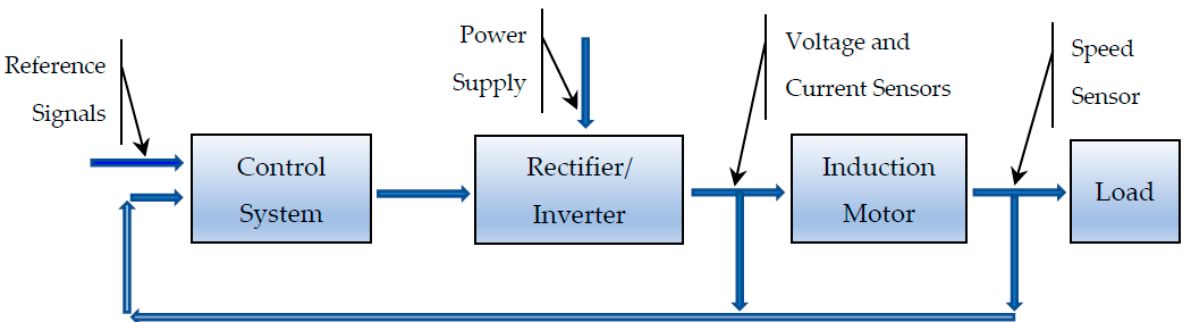
Figure 1. Block diagram of the IM scalar control system.